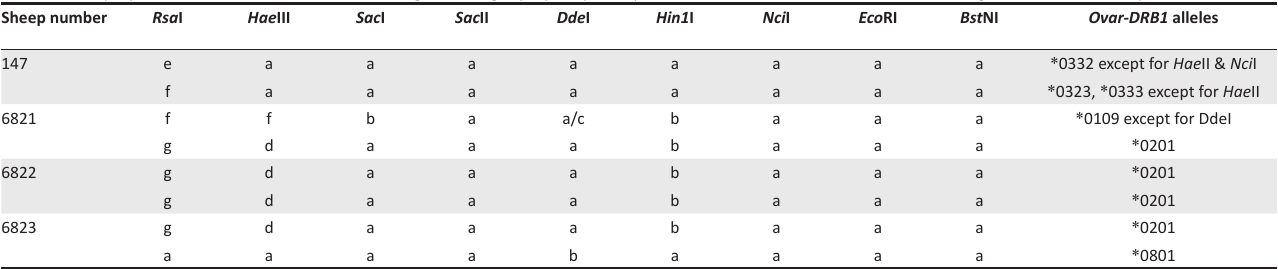
TABLE 7: The polymerase chain reaction-restriction fragment length polymorphism patterns and Ovar-DRB1 alleles obtained using nine restriction enzymes. Sheep number